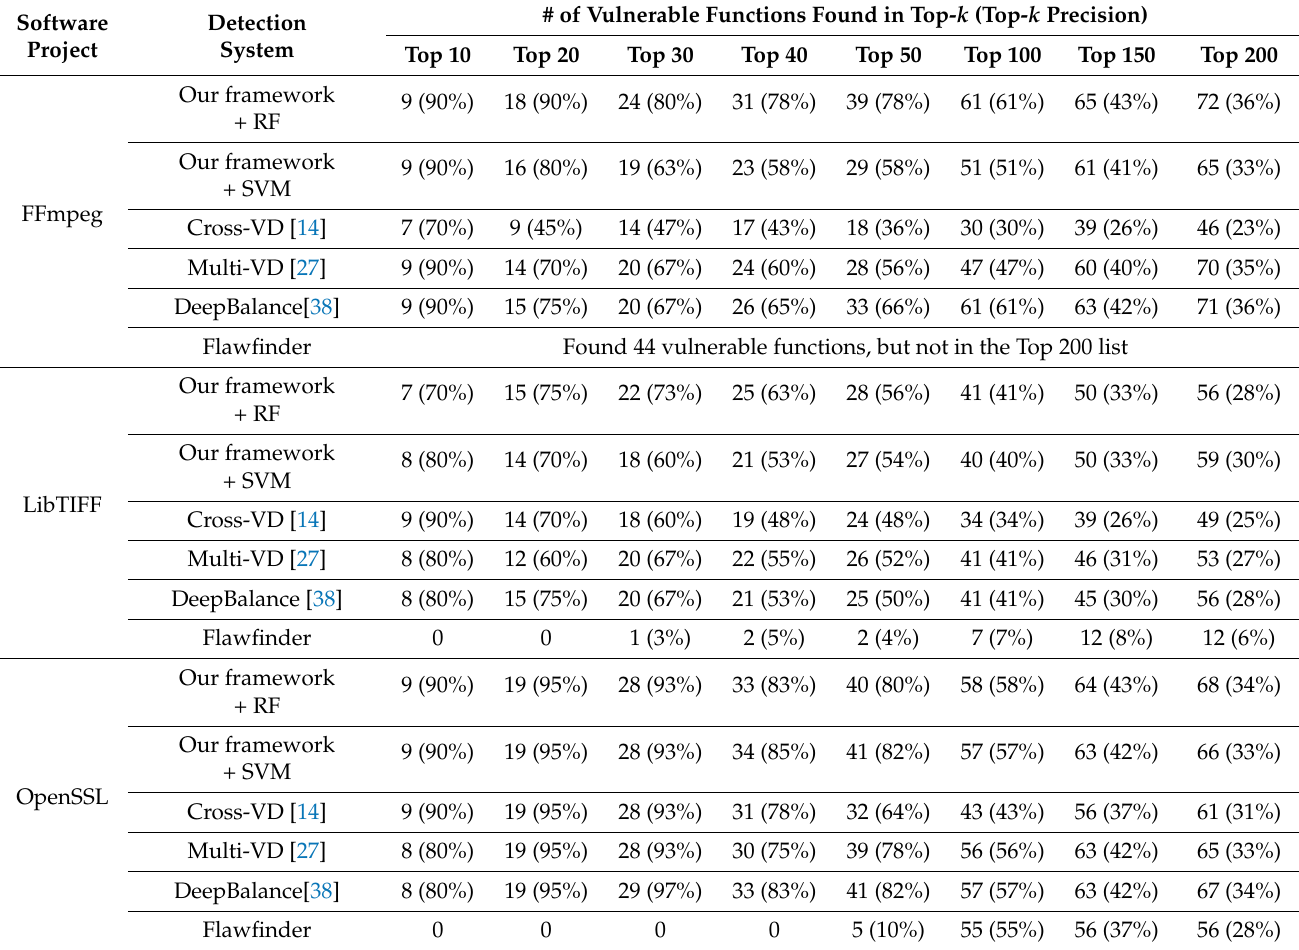
Table 4. The results of performance comparison among our framework (with random forest (RF) and SVM), Cross-VD [14], Multi-VD [27], DeepBalance [38] and Flawfinder on three open-source projects: FFmpeg, LibTIFF, and OpenSSL.